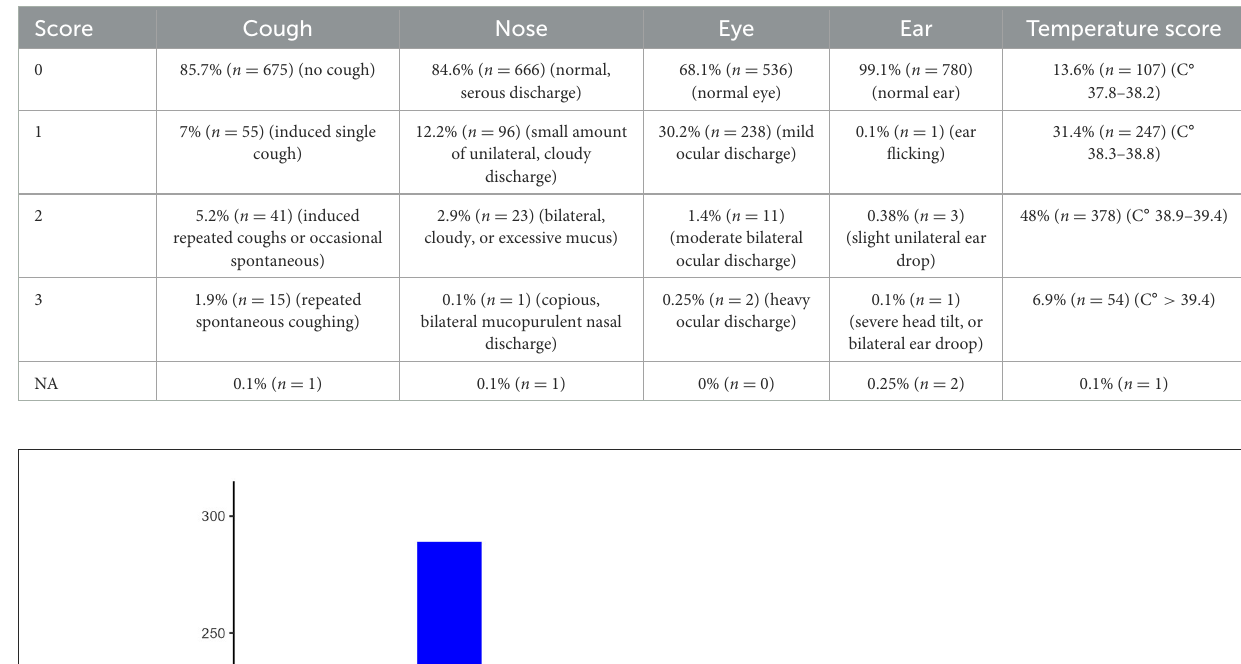
TABLE 1 Frequency of occurrence (%, no. calves) of each score for each of the components of the Wisconsin respiratory score.